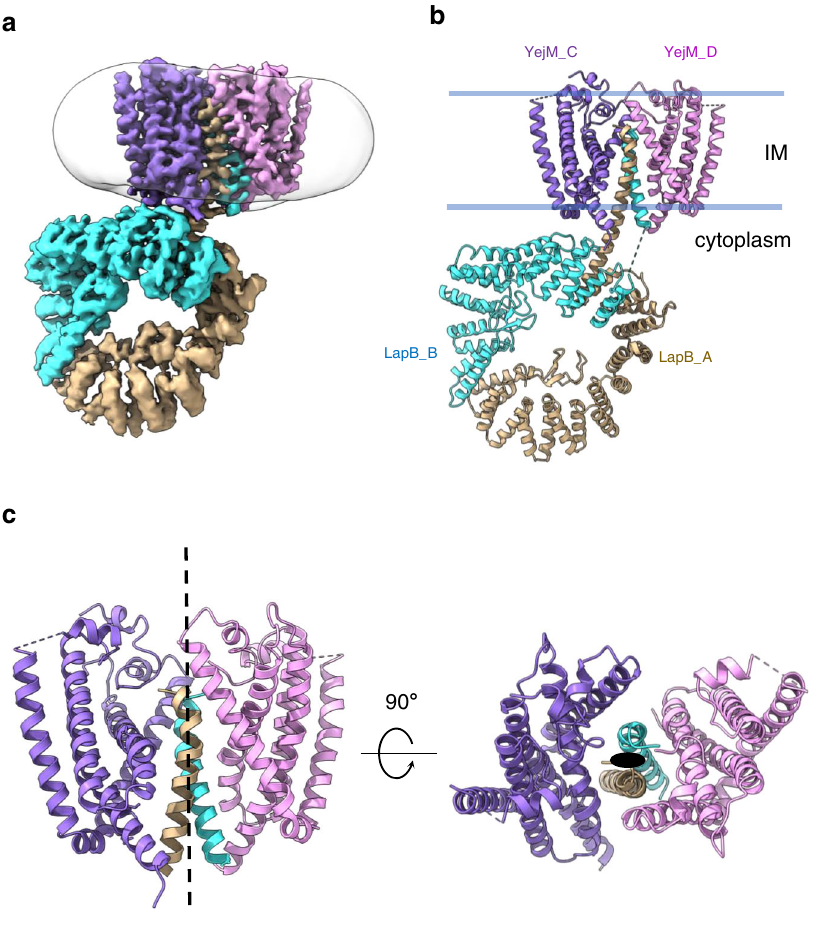
Fig. 2 | CryoEM structure of the YejM/LapB complex. a Surface view of 3D reconstruction of the YejM/LapBcomplex, fi ltered to 3.9Åresolution.Volumesfor proteins are presented with a contour level of 0.25. Molecules of LapB_A, LapB_B, YejM_C,andYejM_Darecoloredinbrown,cyan,purple,andpink,respectively.The volumeforthedetergentmicelleissmoothenedwithaGaussian fi lterandshownas